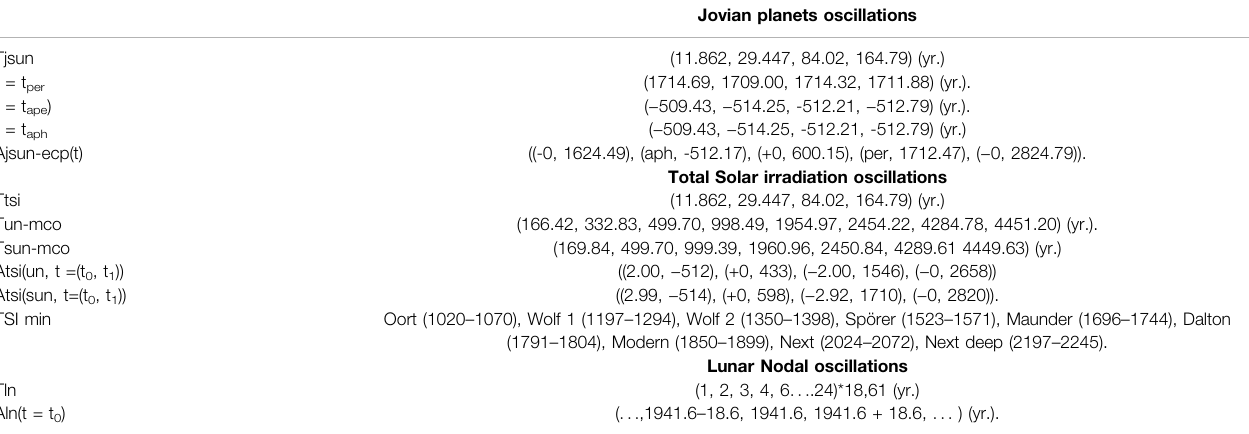
TABLE 1 | Cycle- and phase-coincidences between Jovian planet oscillations (JSUN), total solar irradiation oscillations (TSI) and lunar nodal forced sea temperature oscillations (LST).